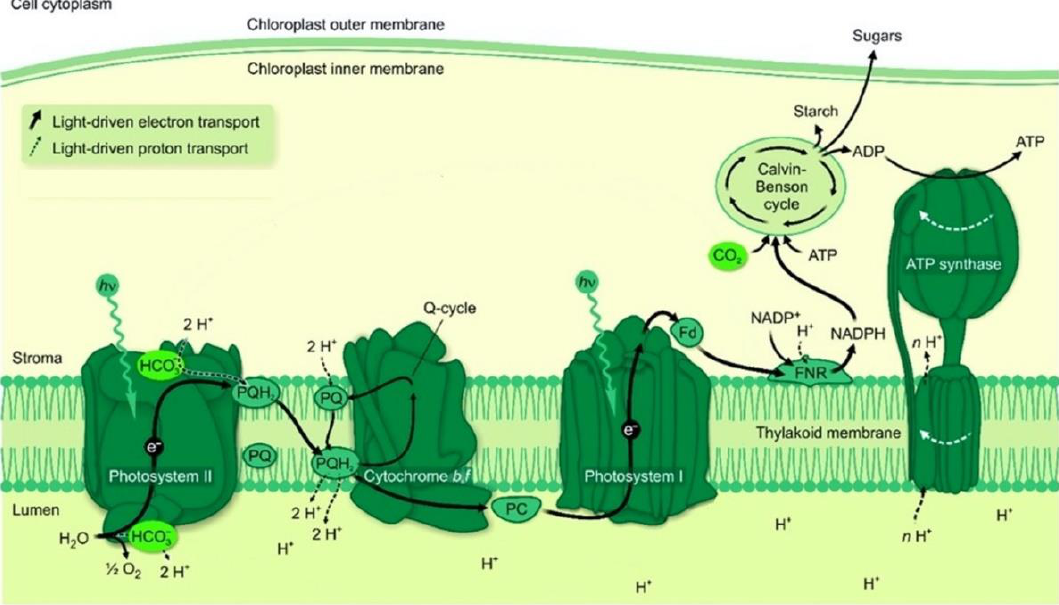
Figure 1. Thylakoid membrane with photosynthetic protein complexes and sites of bicarbonate action. Slightly modified from Shevela et al. [4]. Reprinted with permission from [4]. © 2020 American Chemical Society. Reproduced under the Creative Commons Attribution (CC-BY) License (https://pubs.acs.org/page/policy/authorchoice_ccby_termsofuse.html, 27 July 2022).